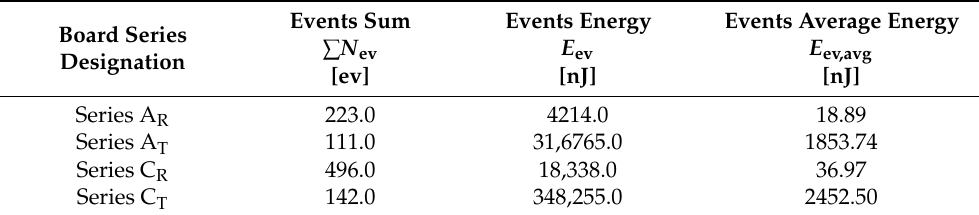
Table 3. Summary of representative values of events sum ∑ N ev , events maximum energy E ev and events average energy E ev,avg for boards of series A R and C R in dry-air condition and series A T and C T exposed to temperature of 230 ◦ C for 3 h.